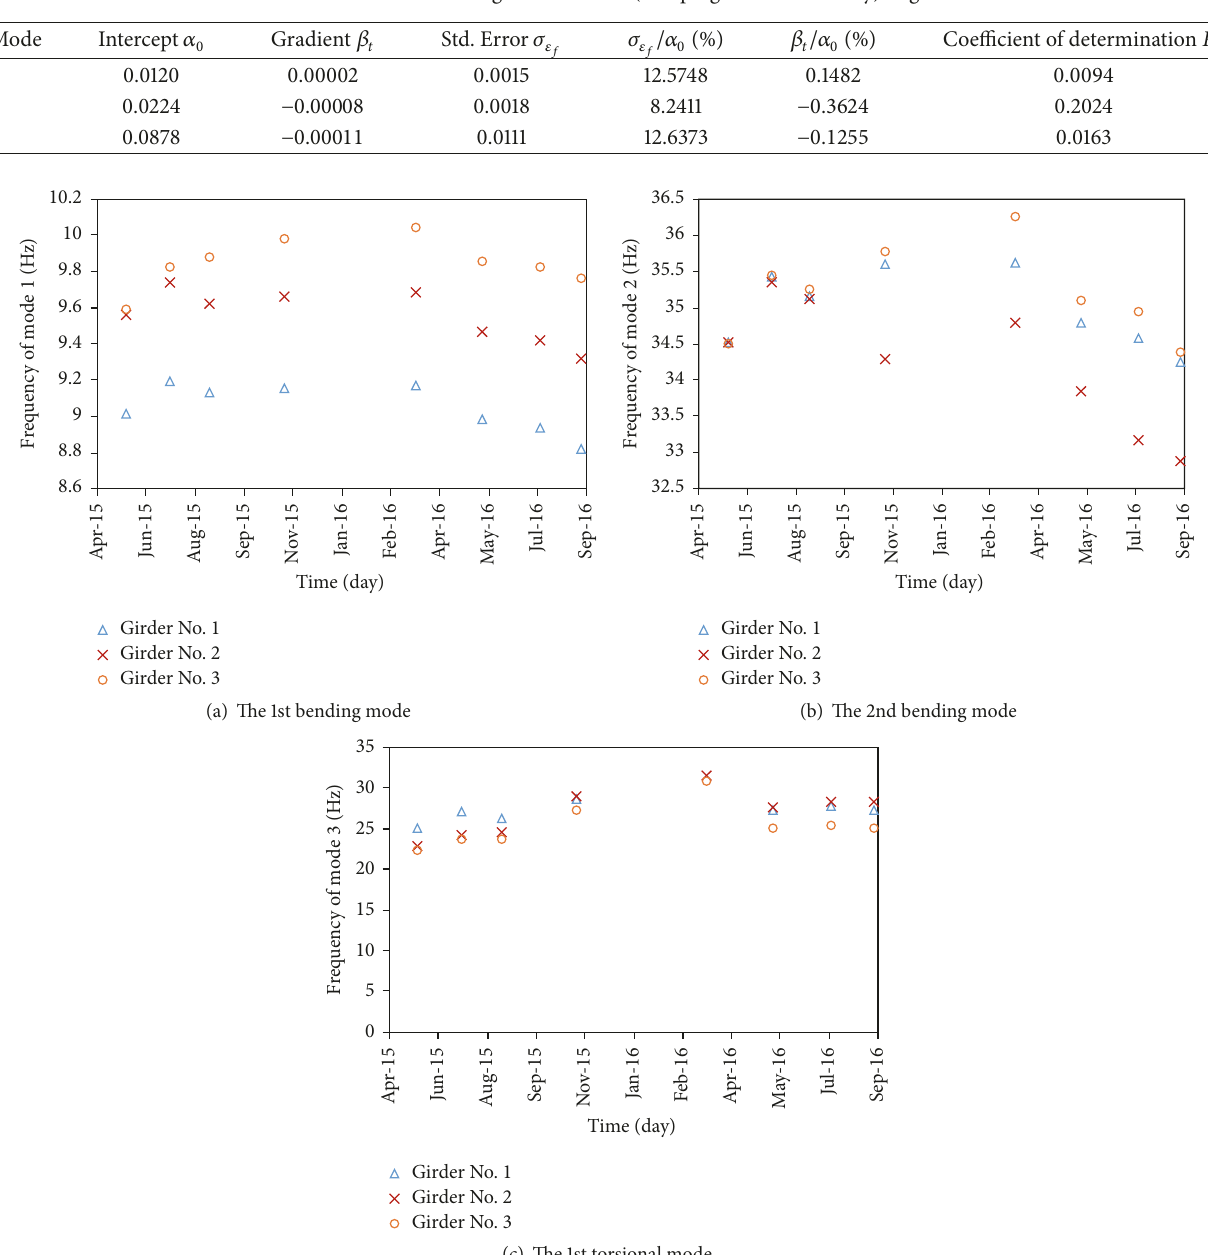
Table 12: Coefficients of linear regression model (damping ratio ∼ humidity) of girder No. 3.